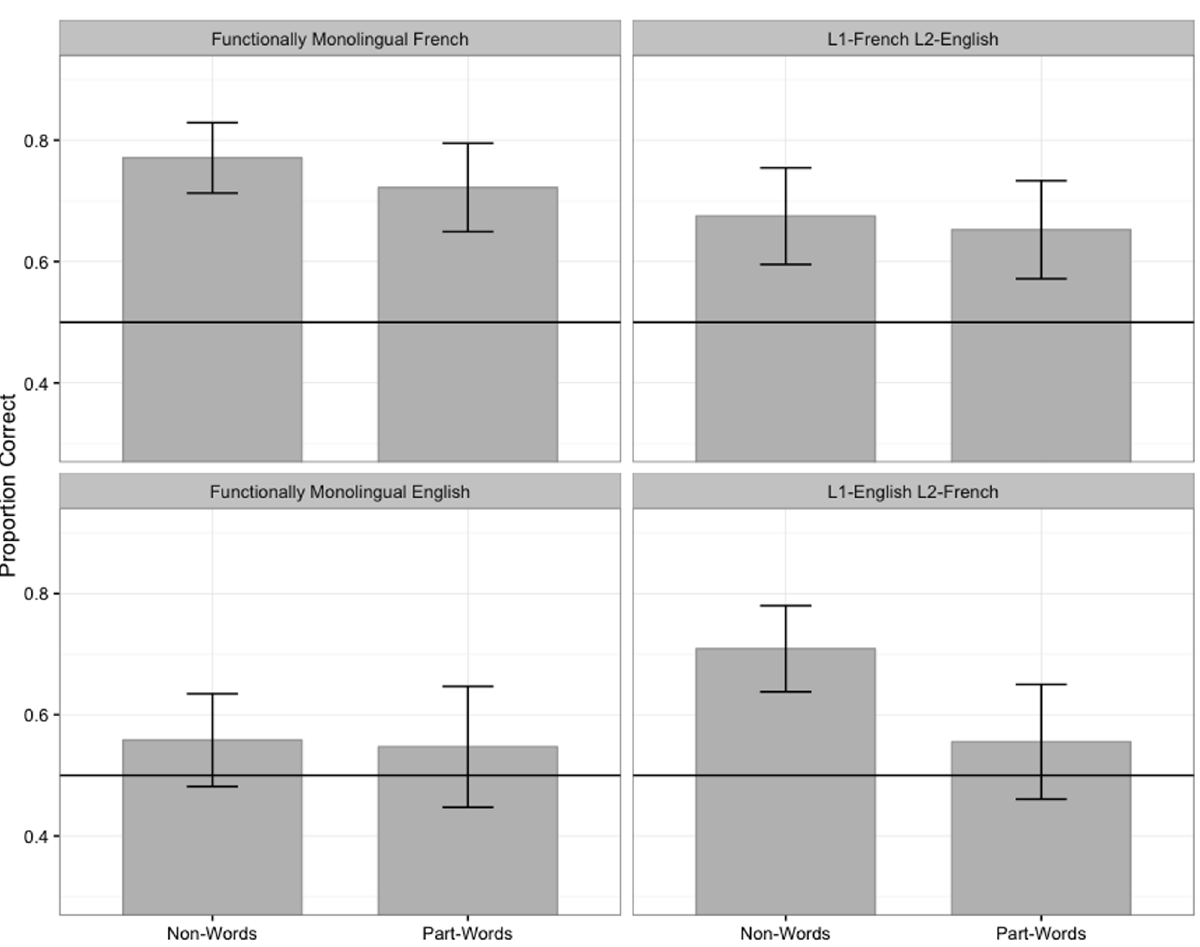
Fig 3. All listeners’ mean proportions of correct responses in the condition with F0 cues to word-final boundaries. The error bars represent one standarderror of the mean; the horizontalline representschance performance.